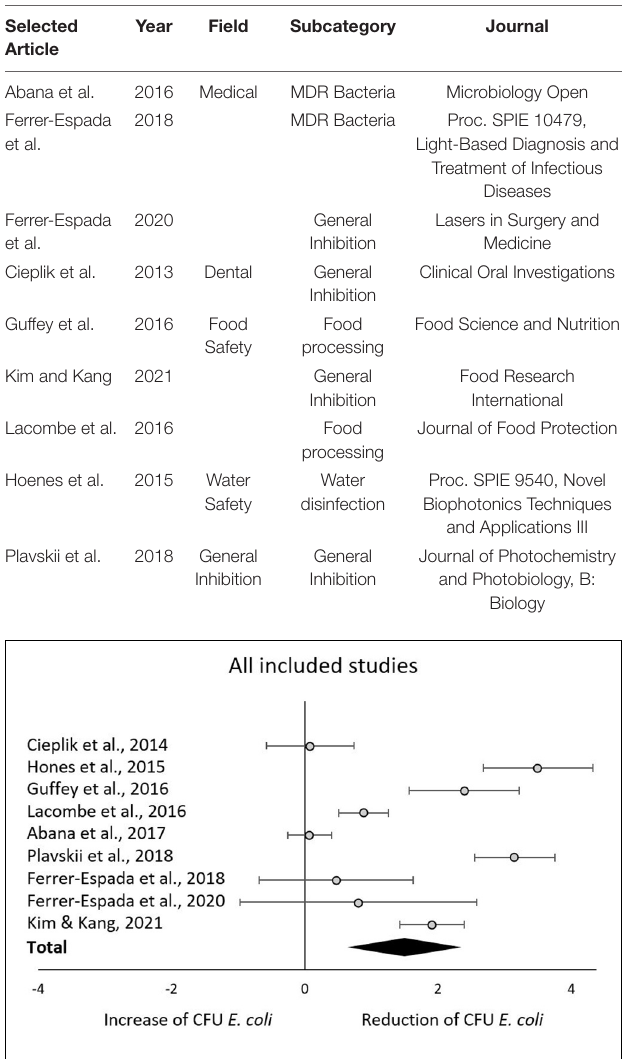
TABLE 1 | Included journal articles for this meta-analysis organized by the field of study that used for blue light inhibition of E. coli .